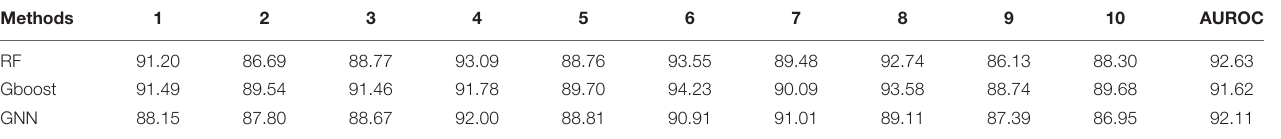
TABLE 10 | Ten-fold cross validation accuracies for link prediction using RF, Gboost, and GNN in DDKG.